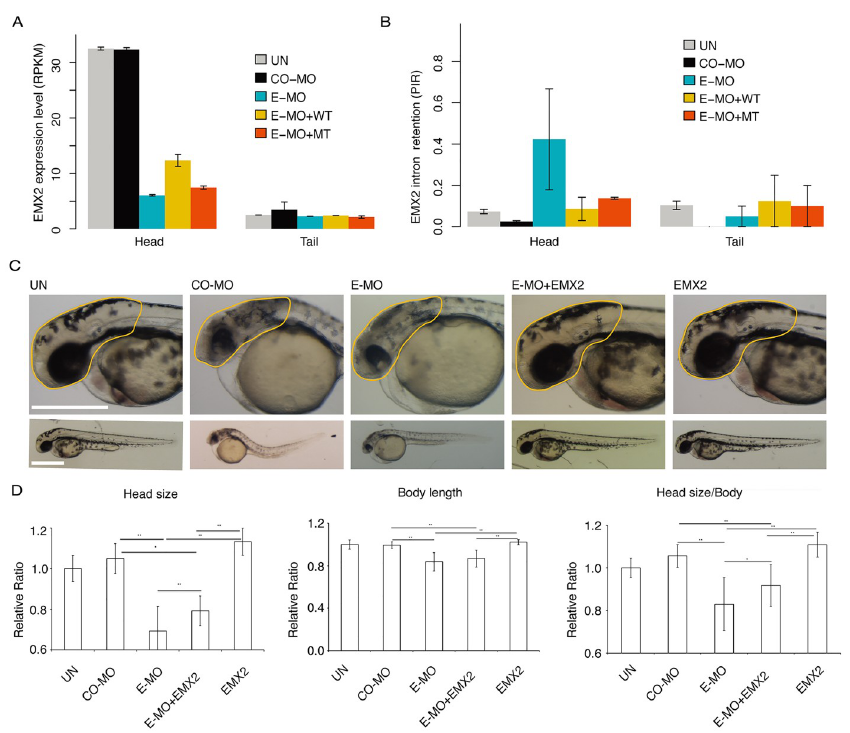
Fig 6. The brain defect caused by SNPRE/SmE deficiency can be partially rescued by transcription factor EMX2. (A), The expression of EMX2 gene is specifically disturbed in head of zebrafish after zSmE deficiency. (B), The zSmE deficiency leads to increased intron retention of EMX2. (C), The head defect caused by zSmE deficiency can be partially rescued by transcription factor EMX2. The morpholino and/or in vitro transcribed RNA is injected into embryo at 1-cell stage. Yellow line marked the region for quantification. (D), Quantification of zebrafish head size. Left, head size; middle, body length; right, head size normalized by body length. UN, un-injected; CO-MO, control morpholino; E-MO, SmE morpholino, EMX2, EMX2 gene in vitro transcript. The UN is normalized to 1. � P < 0.05; �� P < 0.01.